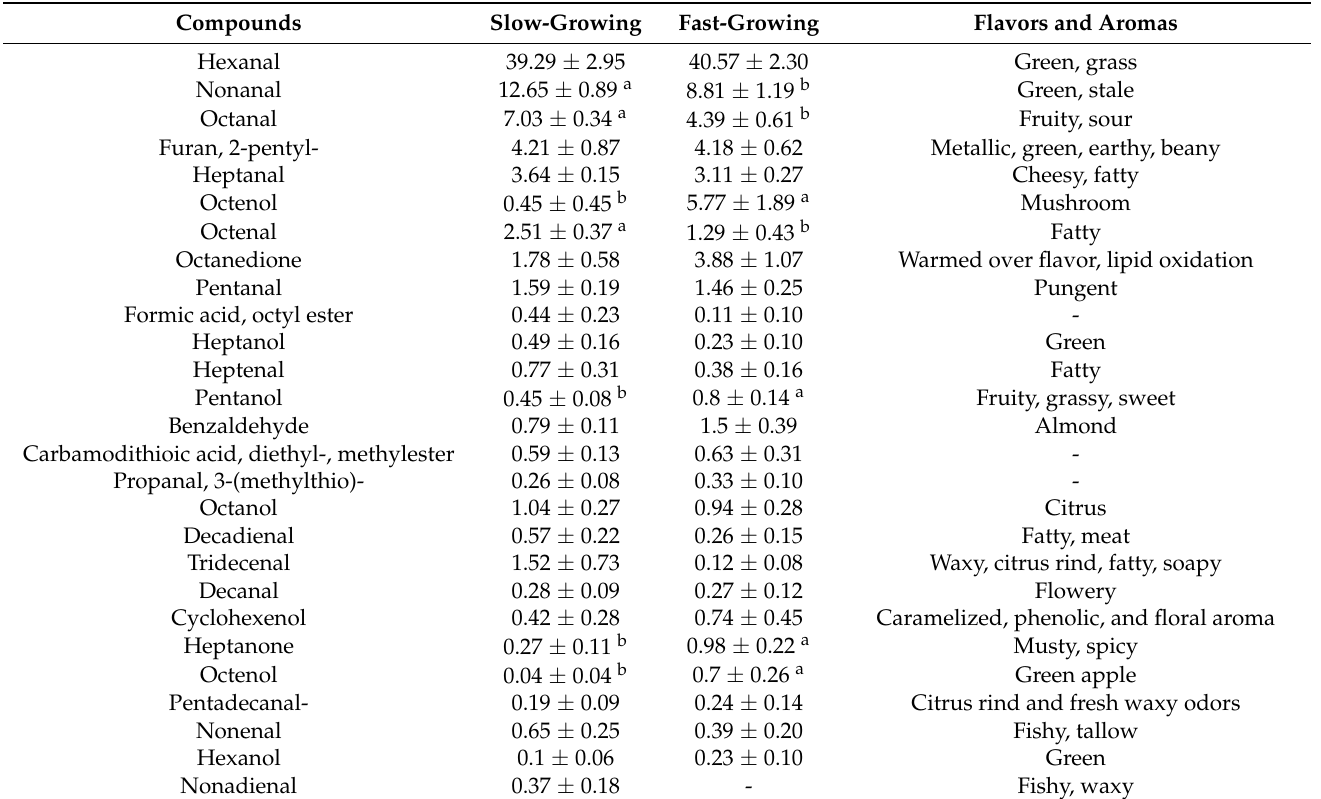
Table 5. Comparison on contribution rates (%) of volatile compounds from slow- and fast-growing duck